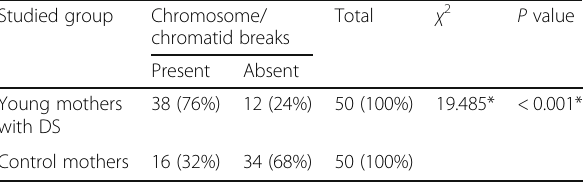
Table 2 Association between chromosome/chromatid breaks and young mothers with DS in comparison to control mothers Studied group Chromosome/ Total χ 2 P value chromatid breaks Present Absent Young mothers with DS